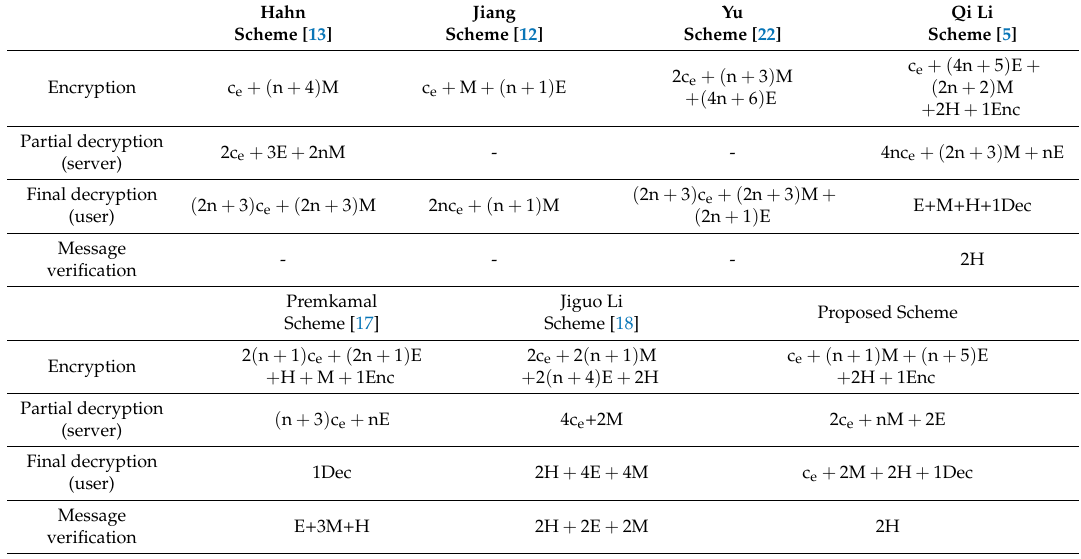
Table 4. Comparing the computation amount of this proposed scheme with existing CP-ABE